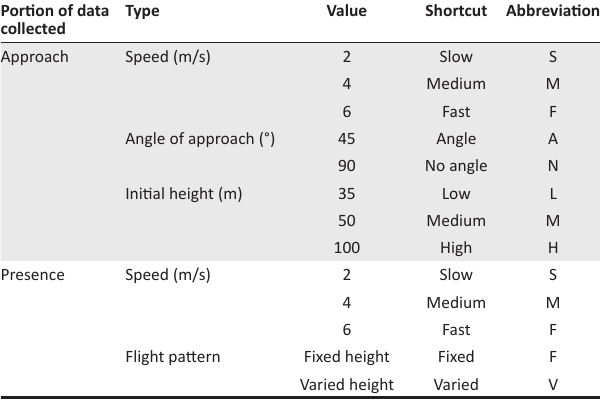
TABLE 1: The variables used throughout the approach and presence portions of data collection with the corresponding ‘shortcuts’ and abbreviations. Portion of data